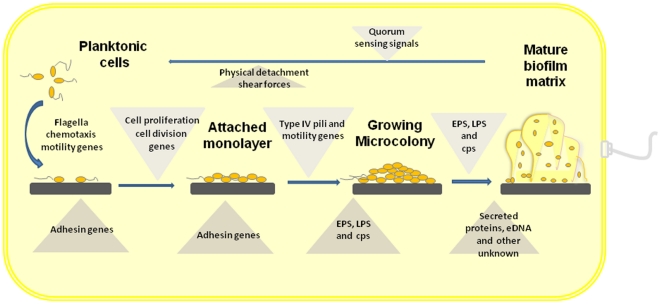
Schematic simulation of the multistage biofilm formation process in X. axonopodis pv. citri.The counterclockwise cycle initiates with the attachment of individual cells developing into a three-dimensionally complex, multicellular biofilm matrix. Eventual dispersal releases a subpopulation of cells from the biofilm matrix into the planktonic phase.